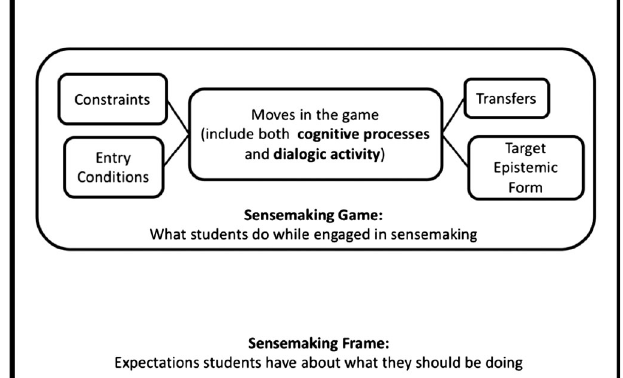
FIG. 1. Theoretical connections between the epistemic games framework and sensemaking framing, dialogue, and cognitive